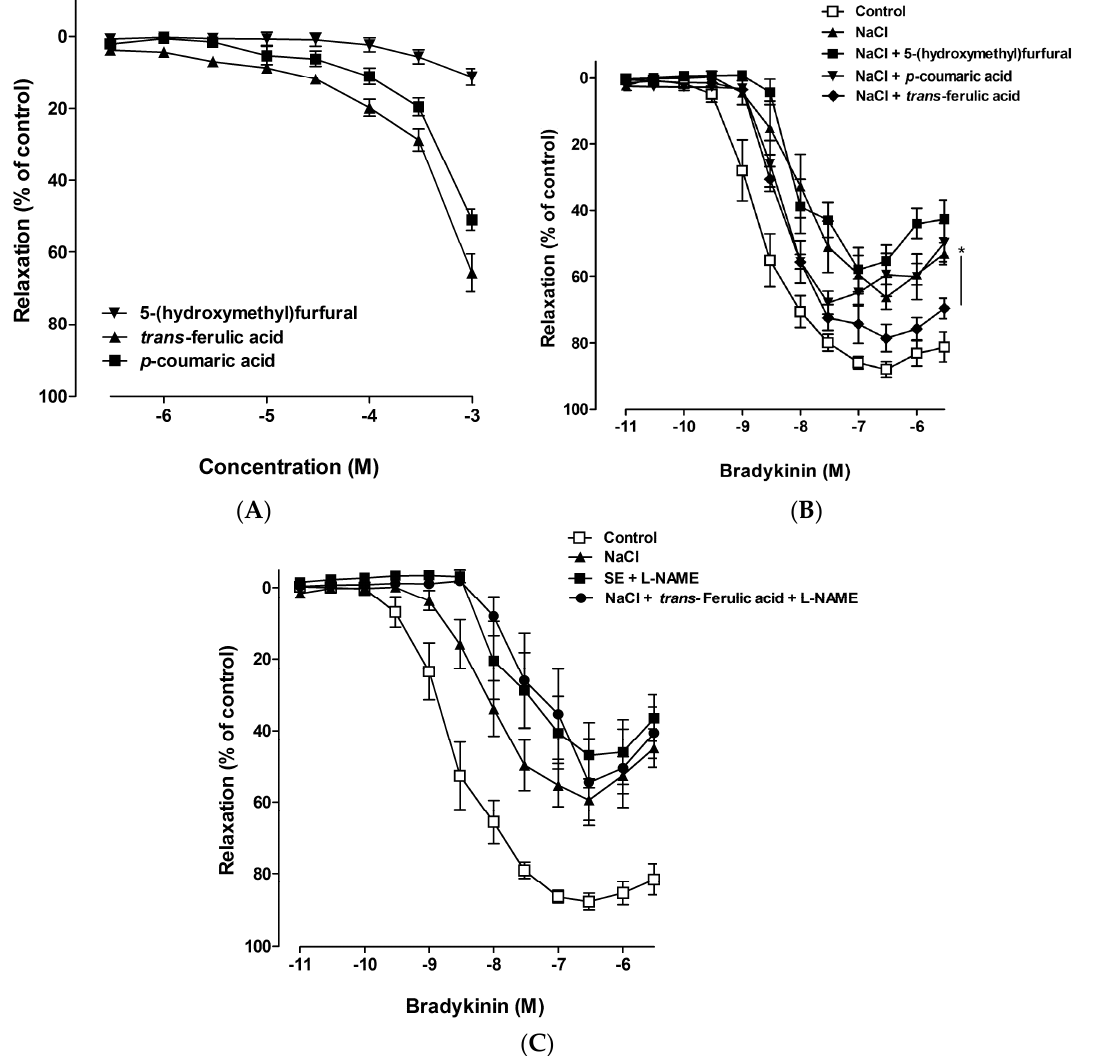
Figure 3. Dose-dependent vasorelaxant effects of 5-(hydroxymethyl)furfural, p -coumaric acid, and trans -ferulic acid in porcine coronary arteries ( A ) and vasorelaxant responses to bradykinin in porcine coronary arteries following incubation for 18 h with a medium containing a high sodium concentration (160 mmol/L) in presence or absence of 5-(hydroxymethyl)furfural (0.1 mmol/L), p -coumaric acid (0.1 mmol/L), and trans -ferulic acid (0.1 mmol/L) ( B ) and pre-treated with L-NAME (an inhibitor of eNOS, 0.1 mmol/L) ( C ). Relaxant responses are expressed as the percentage of relaxation of the initial tone induced by U46619. Values are expressed as mean ± SEM from n = 8 to 10 experiments. Concentration-response curves were compared using two-way ANOVA. “*” stands for p < 0.05 vs. NaCl.